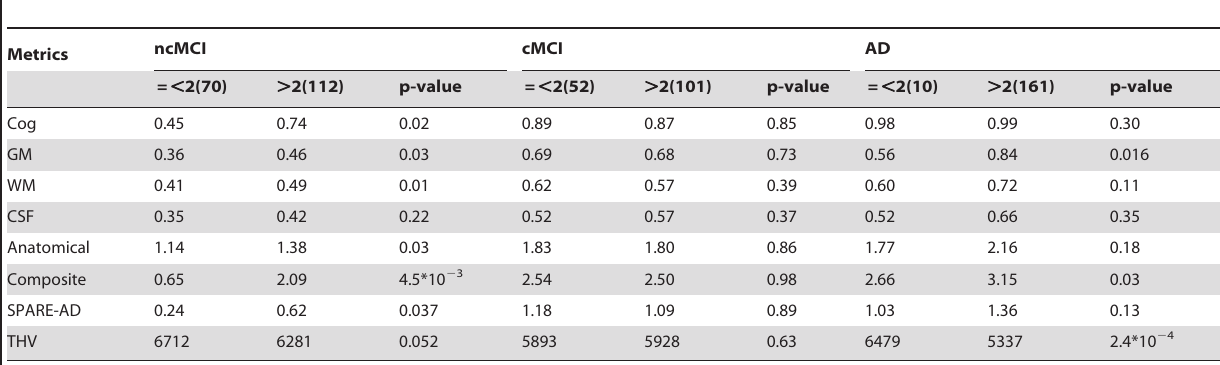
Table 7. Median values of AD-PS scores, SPARE-AD index and total hippocampal volume were estimated across clinical groups by functional status (FAQ # 2 v. .